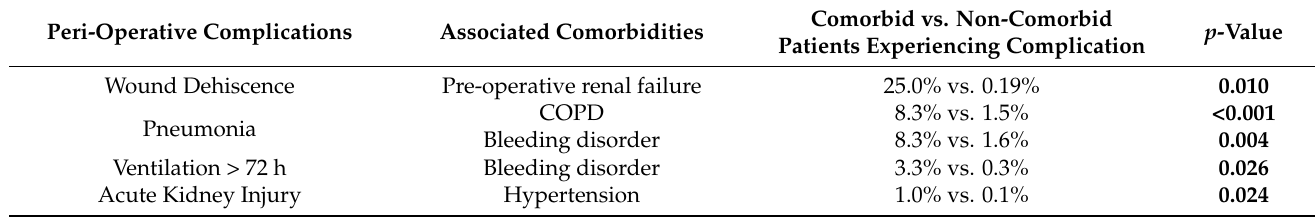
Table 4. Factors significantly associated with complications upon multivariate